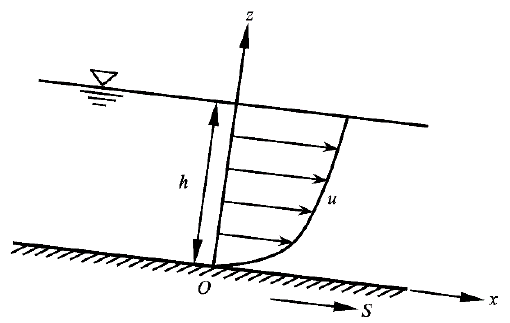
Figure 1. Sketch of two-dimensional (2D) open channel uniform flow.